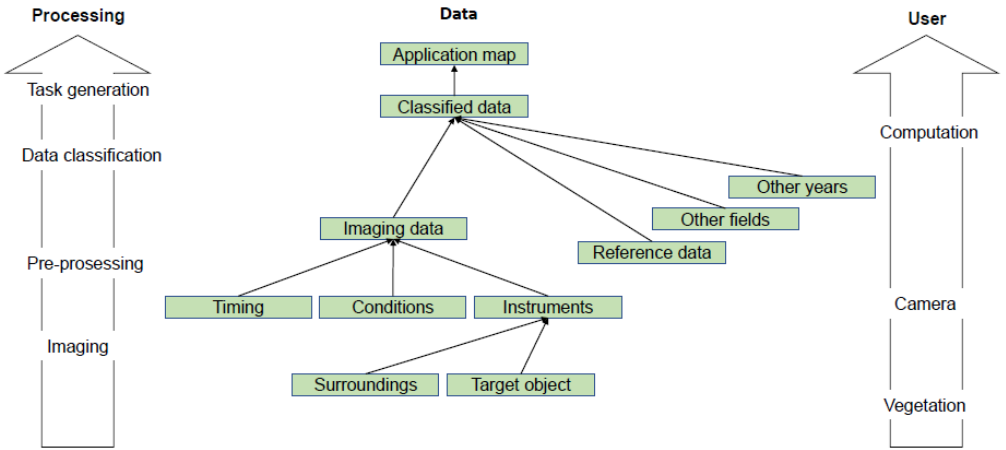
Figure 7. Determined planning process of imaging campaigns: processing of data, data analysis.